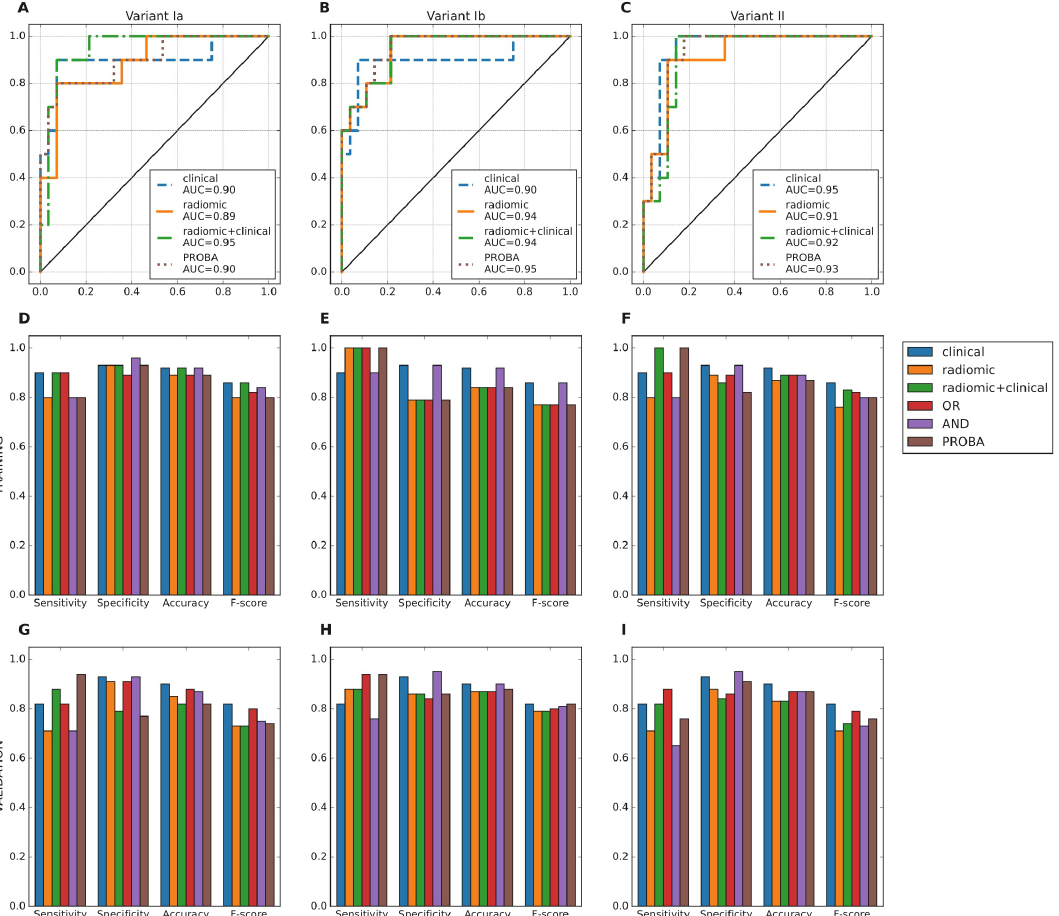
Figure 4. AUC ROC of the selected models (clinical, radiomic, radiomic+clinical) and their ensembles for the training set ( A – C ). Comparison of statistical measures for the selected model architectures of the considered feature sets and ensembles of those models: training ( D – F ) and validation ( G – I